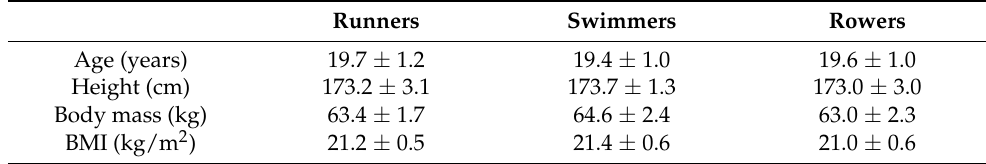
Table 1. Baseline characteristics of athletes. Runners